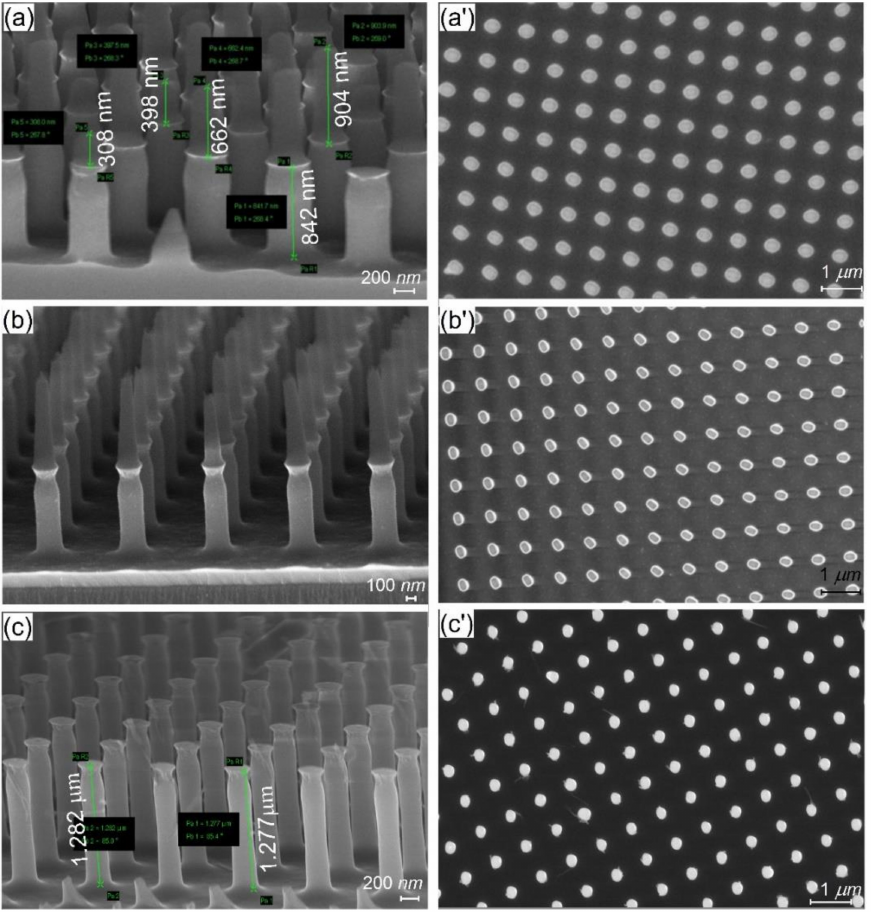
Figure 9. The nanopatterned metalenses via UV-NIL and cryogenic etching method with: mr-NIL 200 nm resist mask side view ( a ) and the respective top view after resist removal using RIE ( a’ ); with mr-NIL 500 nm resist mask side view ( b , c ) and the respective top view after resist removal using RIE etched ( b’ , c’